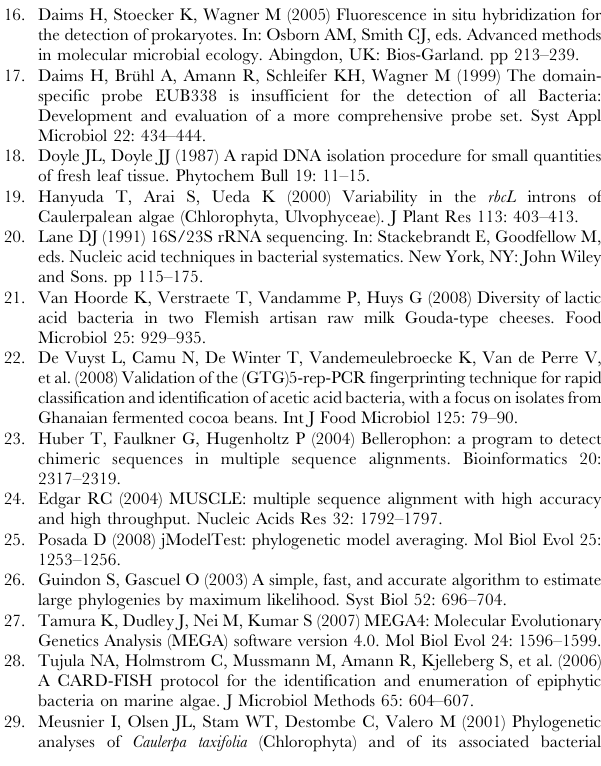
Table S1 Bacterial 16S rRNA gene sequences isolated from algae (excluding BLAST hits) included in the phylogenetic analysis.